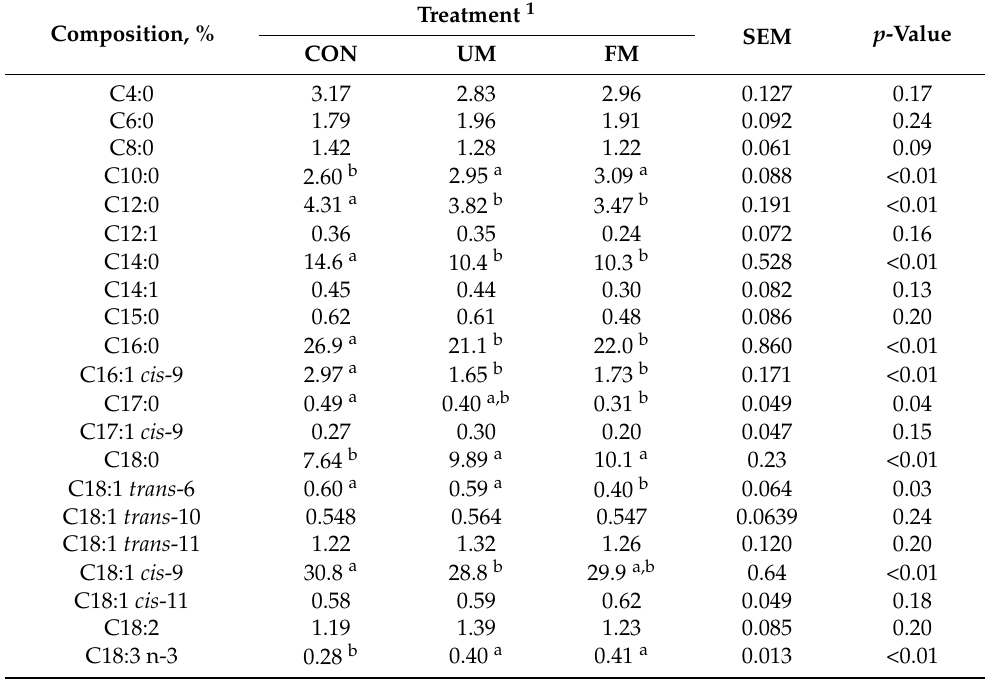
Table 4. Milk fatty acids compositions of lactating cows fed the total mixed rations (TMR) containing unfermented (UM) and fermented yellow wine lees mix (FM). Treatment Composition, %